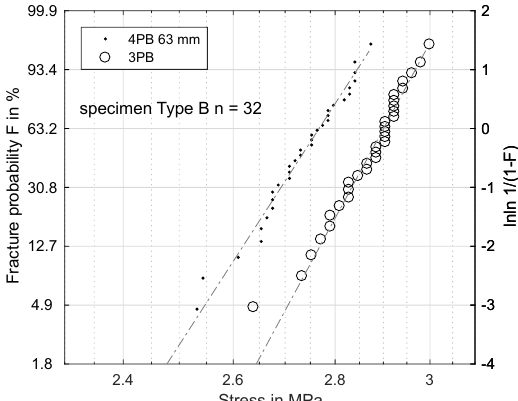
Figure 5. Fracture probability for a 3PB and a 4PB (load distance 63 mm) dataset with different effective